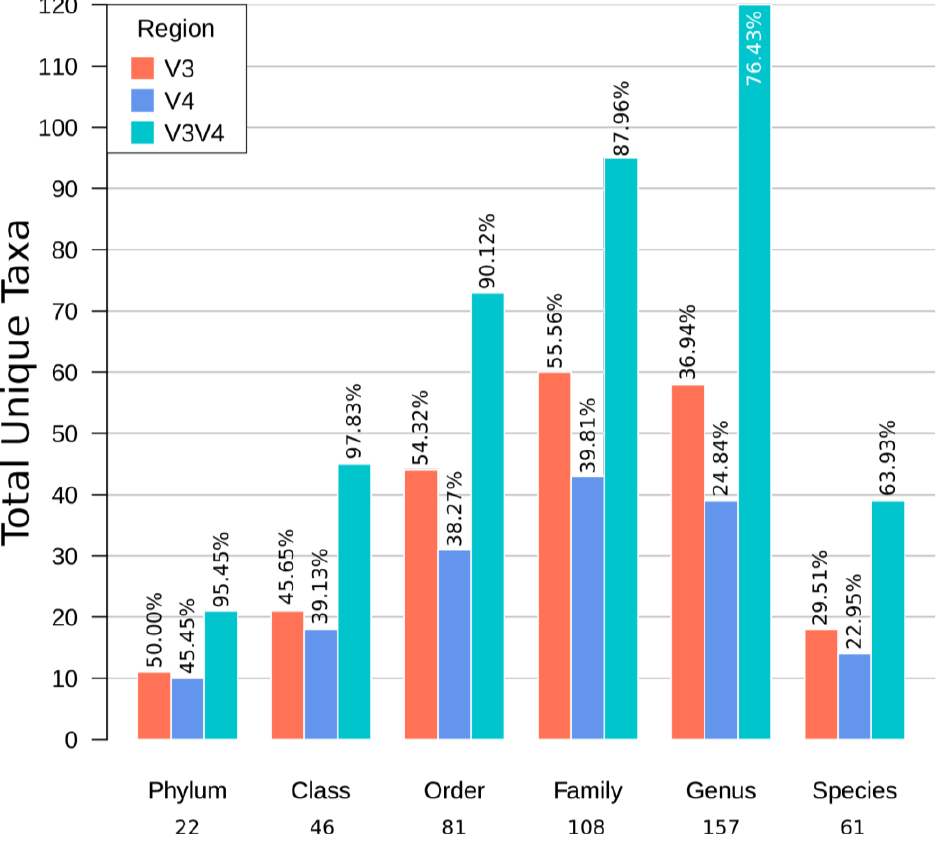
Figure 5. Total taxa and a percentage per taxonomic level and region. The total taxa at the phylum, class, order, family, genus, and species levels are shown in the x -axis. The height of the bars represent the total taxa found per region, along with the percentage. Only informative taxa labels were considered. Considering the whole taxonomic composition, Figure 6 shows that the averages of total phyla observations (total sum scaling relative abundance calculated over the mean per subgroup of every observation) were more di ff erent among organs than regions. The V3V4 was the most diverse region, irrespective of the organ, as recovered 11 out of 22 informative phyla, plus, this was the only region to recover any taxa from the Archaea domain. On the other hand, V3 and V4 presented a more similar taxonomic composition and showed that marine Caldithrix as an exclusive phylum to these regions. Notably, all regions assessed Proteobacteria as the most abundant phyla, accounting for 51.96 ± 21.13% of the whole set, with a higher prevalence in the hepatopancreas (61.72 ± 18.09%) than in intestine (42.20 ± 19.95%). Contrastingly, the second most abundant phyla was clearly Cyanobacteria for the intestine (41.92 ± 11.71%) but was not so consistent in the hepatopancreas, where the V3V4 region estimates Cyanobacteria with 7.55 ± 11.71% while V3 detects Actinobacteria as the second most abundant with 23.68 ± 3.88% and V4 Firmicutes with 10.27 ±